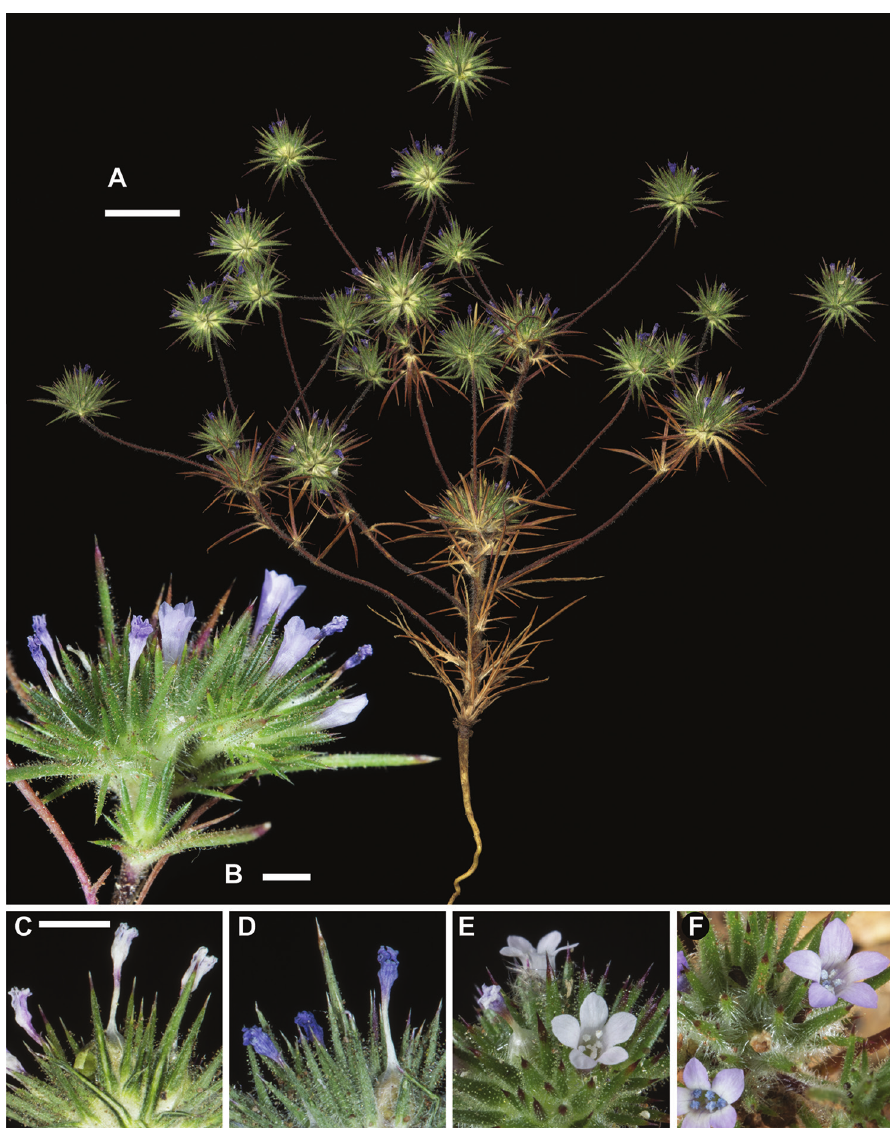
Figure 6. Navarretia aeroides . A Pressed specimen showing plant habit, scale bar = 1 cm ( Gowen 1303 ) B Flowering head in the field, scale bar = 2 mm ( Johnson 14-142 ) C–F Equivalent magnification, scale bar = 2mm C, D Pressed flowering head showing range of coloration in dried flowers ( Johnson 16-070, Gowen 1303 , respectively) E, F Fresh flowers showing range of coloration ( Johnson 16-063a, Johnson 15- 065, respectively). All photographs by L. A. Johnson and vouchers deposited at BRY. order branches or within 1 cm of a head; stem and branches reddish-brown, glandular- pubescent or sparingly so, the trichomes mostly less than 0.5 mm long; distal-most branches filiform, generally no more than 0.3 mm in diameter. Cotyledons two,